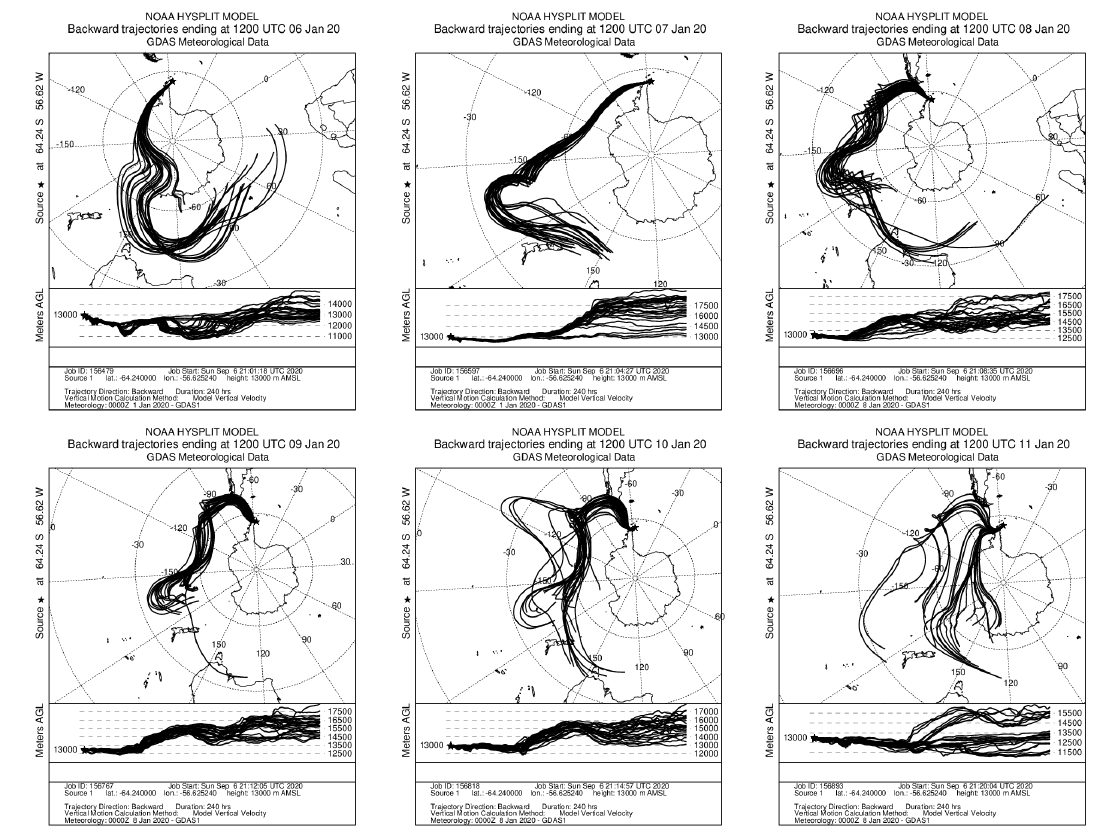
Figure 4. Ensemble HYSPLIT 10-days back-trajectories computed from Marambio at 13 km asl